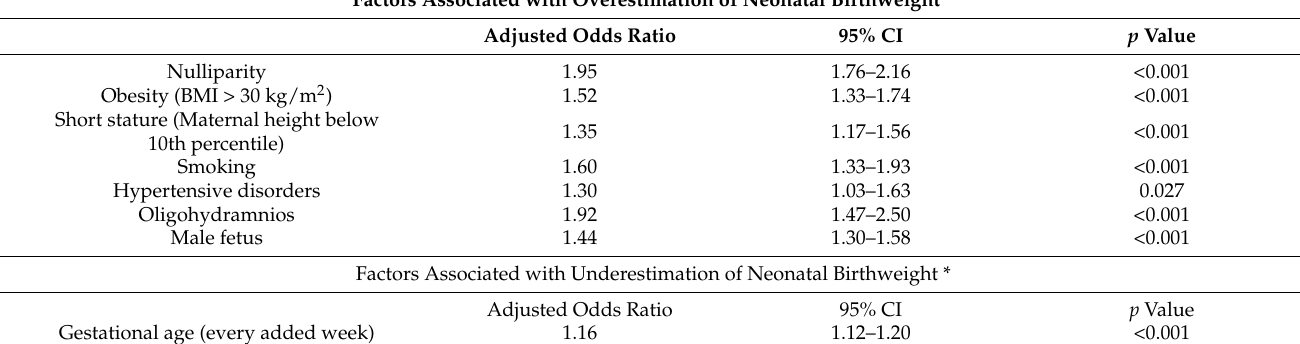
Table 3. Multivariable logistic regression analysis—clinical factors associated with overestimation or underestimation of neonatal birthweight.